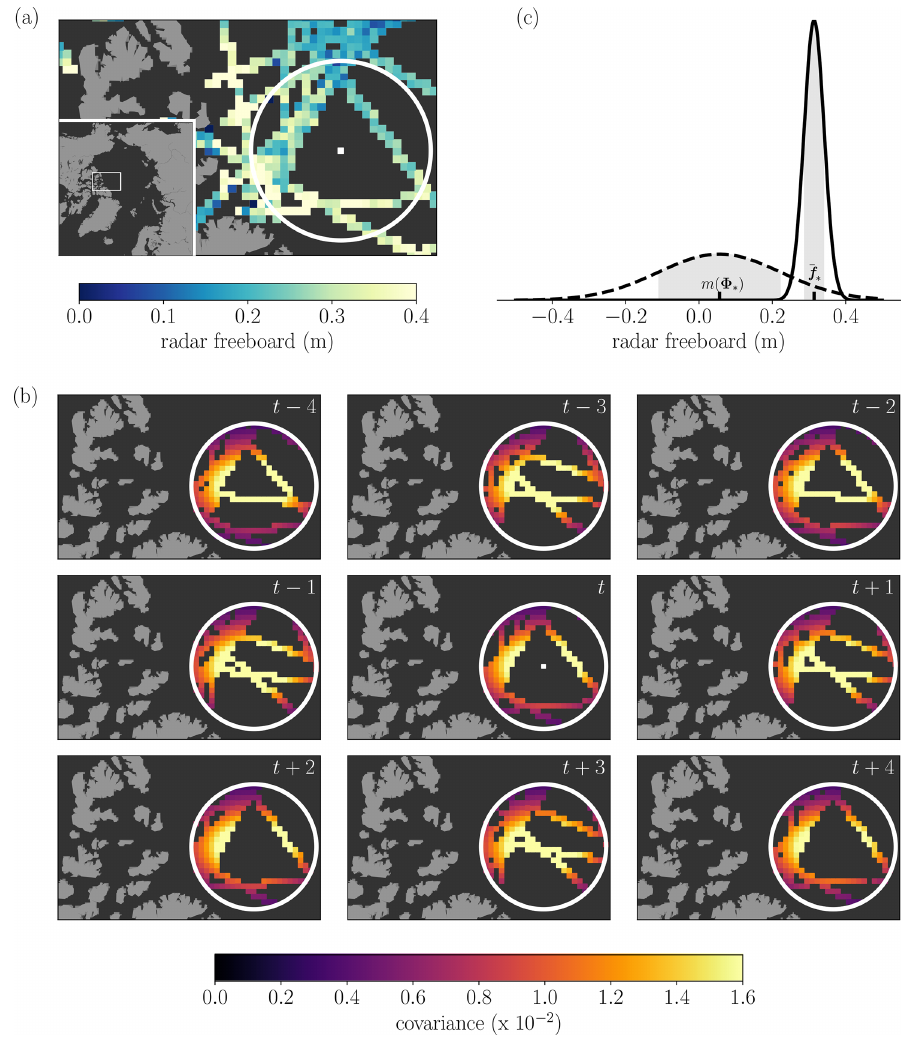
Figure 2. Estimating freeboard for one grid cell. (a) In this case we want to estimate a posterior distribution of freeboard values at the location of the white pixel on day t . The white circle corresponds to a distance of 300km from the pixel, and the gridded tracks are the CS2 and S3 observations on day t . (b) The prior covariance k( (cid:56) ∗ , (cid:56) ) , which is the covariance between the test input (cid:56) ∗ (the white pixel), and all the training inputs (cid:56) that lie within a 300km radius, for each of the 9d of training data. (c) Probability density functions showing the √ k( (cid:56) ∗ , (cid:56) ∗ ) = 0 . 167m, as well as the prior distribution of function values (dashed), with mean m( (cid:56) ∗ ) = 0 . 056 m and 1 standard deviation posterior predictive distribution (solid) showing the estimated freeboard value at the location of the white pixel on day t as ¯ f ∗ = 0 . 314m, = 0 . with 1 standard deviation of σ f ∗